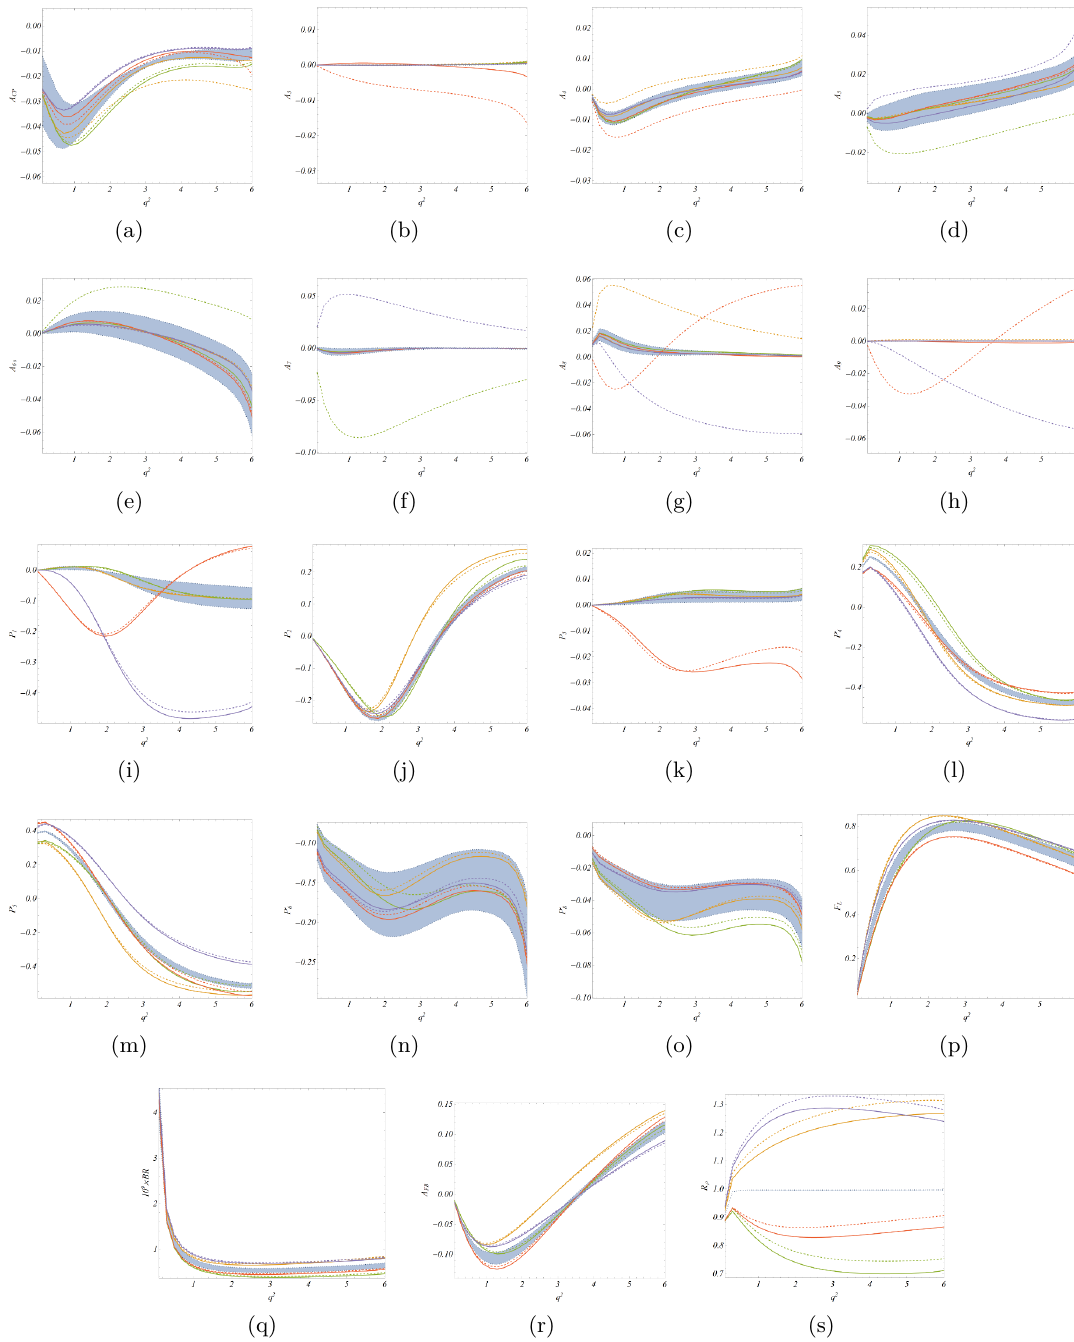
¯ B 0 ) → ρ 0 ll , P , P 0 , F and 5 , 6 s, 8 , 9 1 L 4 , 6